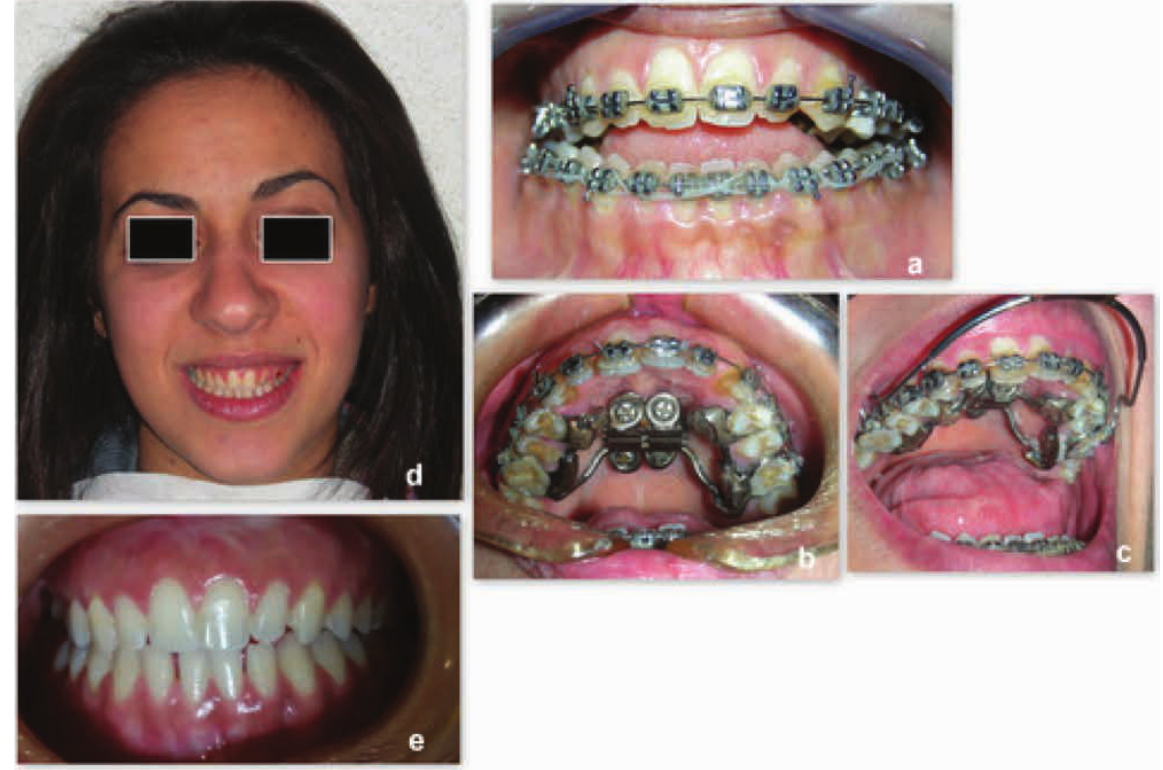
Figure 1: Case 2 a) pre-operative view showing molar cross bite and anterior open bite; b) palatal distractor fixed in paramedian site by